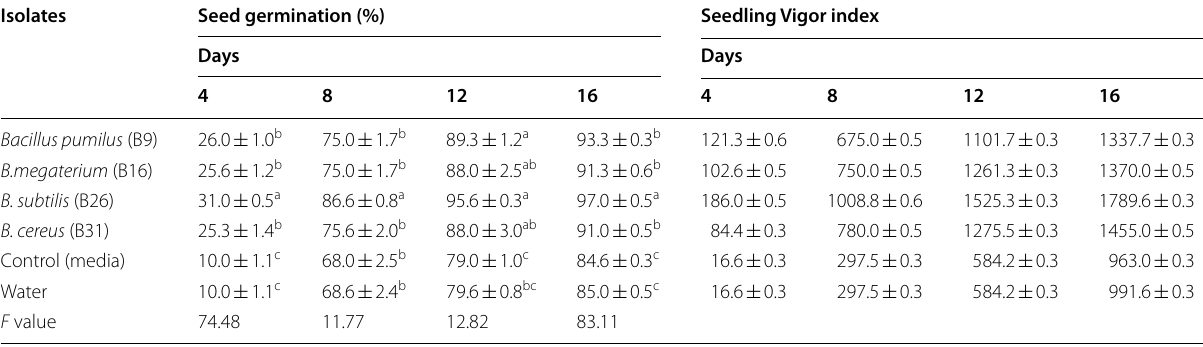
Numerical values are Mean DW, distilled water; media, nutrient agar media; seedling vigor index, germination (%)